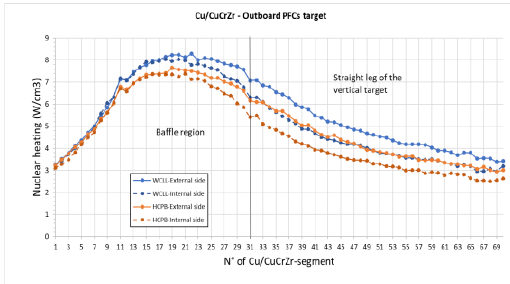
case. case. blanket case.